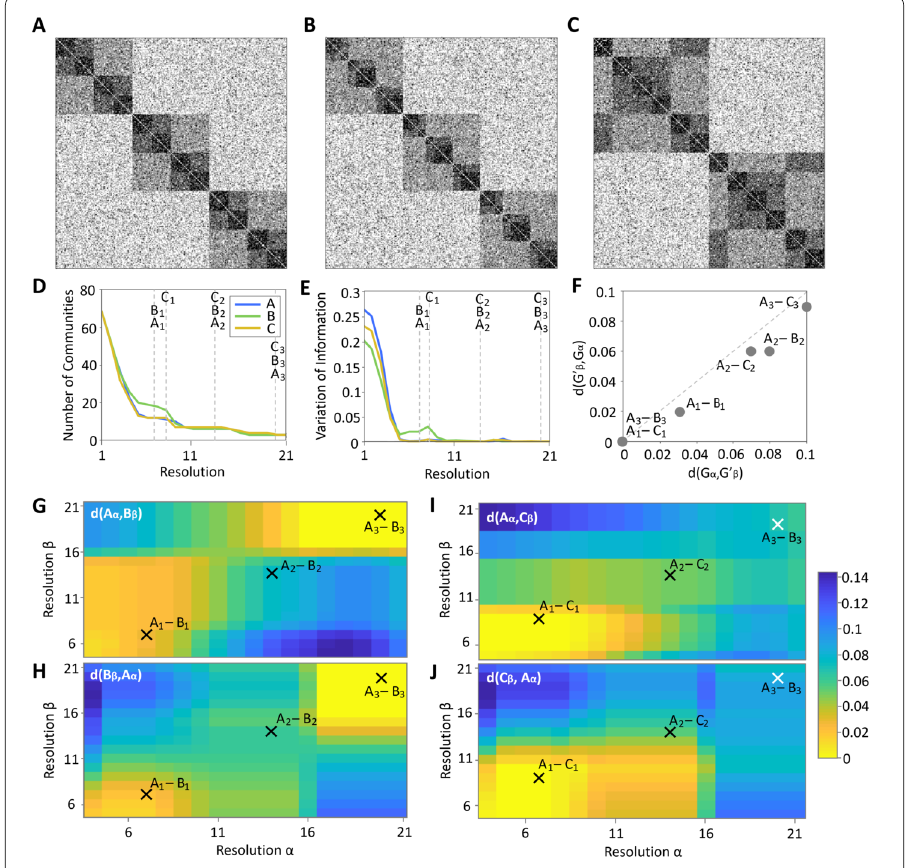
Figure 6 We illustrate the use of the BiDir distance to compare the modular structure of three nested SBMs. ( A )–( C ): We visualize a single network realisation for each SBM. Network A and B share a similar coarse-level community structure with 3 equally sized communities, while A and C share a similar granular-level community structure with 12 equally sized communities. In ( D ) and ( E ): We show the number of communities and the mean variation of information obtained using the Markov stability algorithm for each of the SBMs for a range of resolutions. For each network, we highlight three robust partitions corresponding to distinct scales. ( F ): We show the BiDir distances obtained when comparing these partitions. ( G ) and ( H ): We illustrate the BiDir distances obtained when comparing networks A and B and networks A and C across the full range